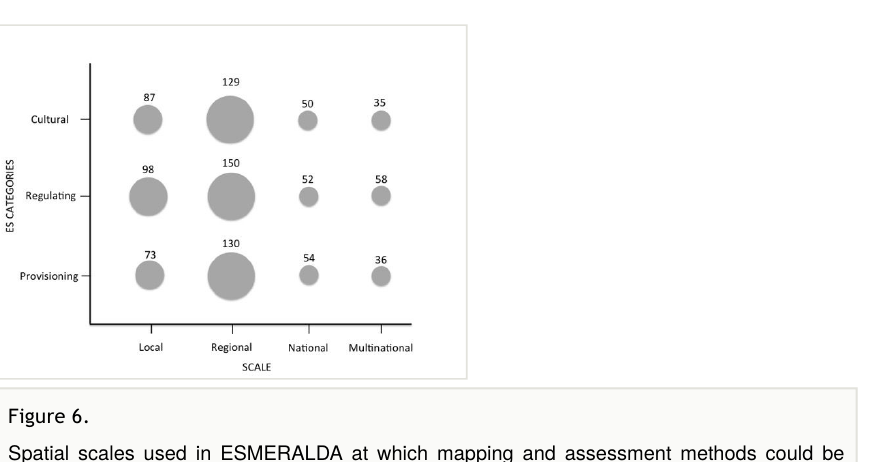
Spatial scales used in ESMERALDA at which mapping and assessment methods could be applied in relation to ES categories.